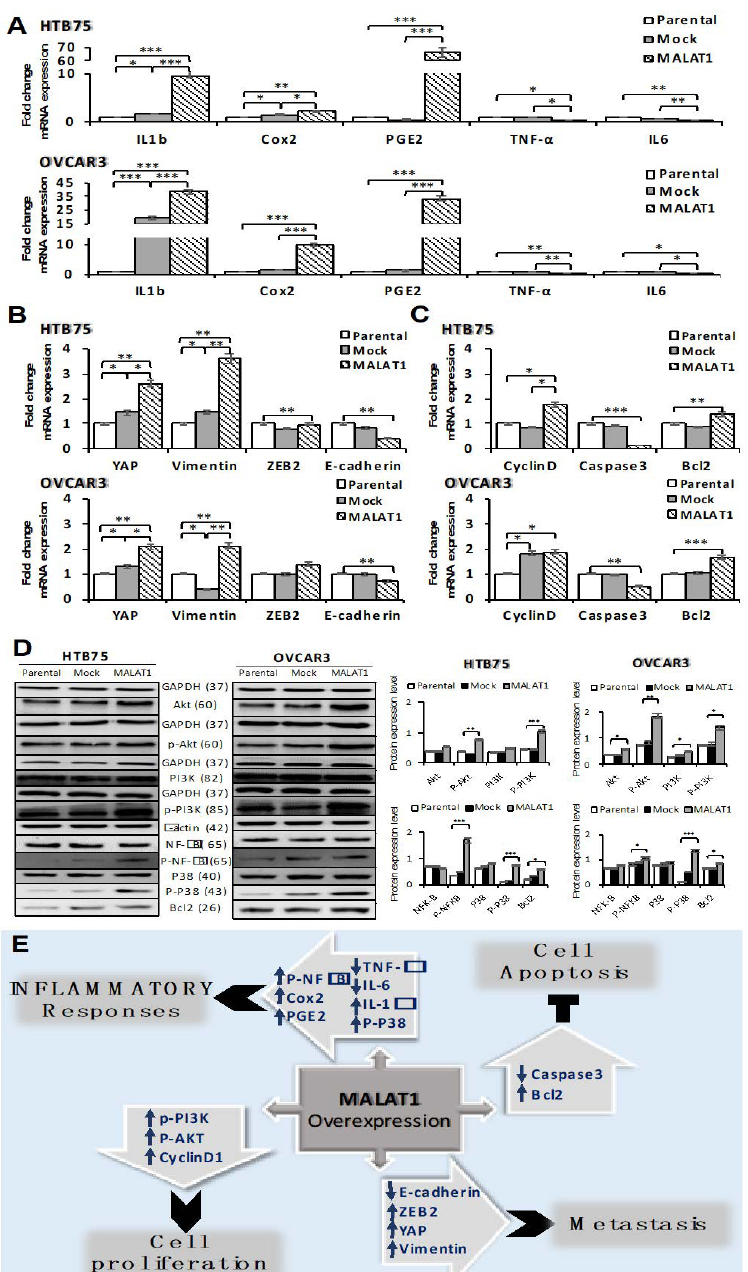
Figure 6. MALAT1 overexpression mediated epithelial ovarian cancer (EOC) progression through enhancing inflammation, cell proliferation, and metastasis, while reducing cell apoptosis: A schematic in vitro model for the overexpression of MALAT1 regulating different functional molecules with similar significance levels in both ( A – C ) HTB75 and ( A – C ) OVCAR3 cells through upregulation of IL-1 β (*** p < 0.001), Cox2 (** p < 0.01 and *** p < 0.001, respectively), PGE2 (*** p < 0.001), YAP (** p < 0.01), Vimentin (** p < 0.01), Cyclin D1 (* p < 0.05), Bcl2 (** p < 0.01 and *** p < 0.001, respectively), and zinc finger E-box-binding 2 (ZEB2) (** p < 0.01 and * p < 0.05, respectively), and downregulation of tumor necrosis factor (TNF)- α (* p < 0.05), interleukin (IL)-6 (** p < 0.01), and E-cadherin (** p < 0.01) mRNA levels by a real-time PCR analysis. Moreover, ( D ) protein levels of phosphorylated (p)-phosphatidylinositol 3-kinase (PI3K) (*** p < 0.001 and * p < 0.05, respectively), p-Akt (** p < 0.01), p-P38 (*** p < 0.001), p-NF κ B (*** p < 0.001 and * p < 0.05, respectively), and Bcl2 (* p < 0.05) were also significantly upregulated in MALAT1-overexpressing HTB75 and OVCAR3 cells by a Western blot analysis. ( E ) Functional mechanisms of MALAT1 overexpression in EOC samples include promotion of inflammation, cell proliferation, and metastasis, combined with inhibition of cellular apoptosis, thereby triggering tumor progression in EOCs. Data shown are the mean ± SD of three independent